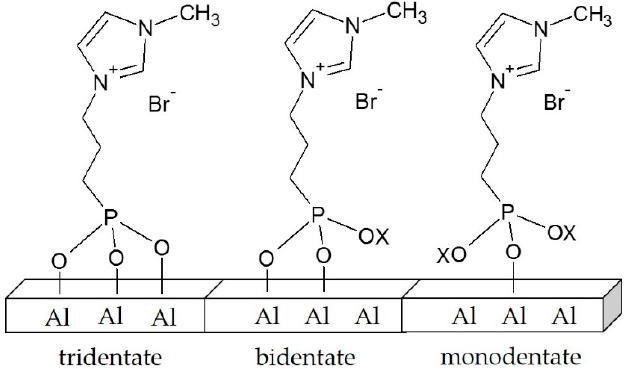
Figure 2. Schematic representation of some possible bonding modes for phosphonate coupling imidazolium-based ionic liquids on a γ -Al 2 O 3 surface (X could be Et or SiMe 3